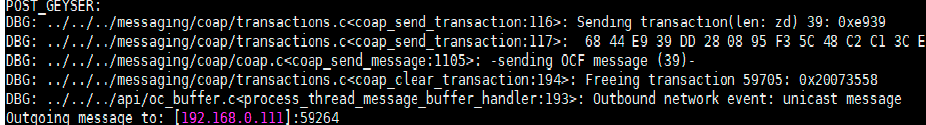
Figure 11. HAN server POST response .